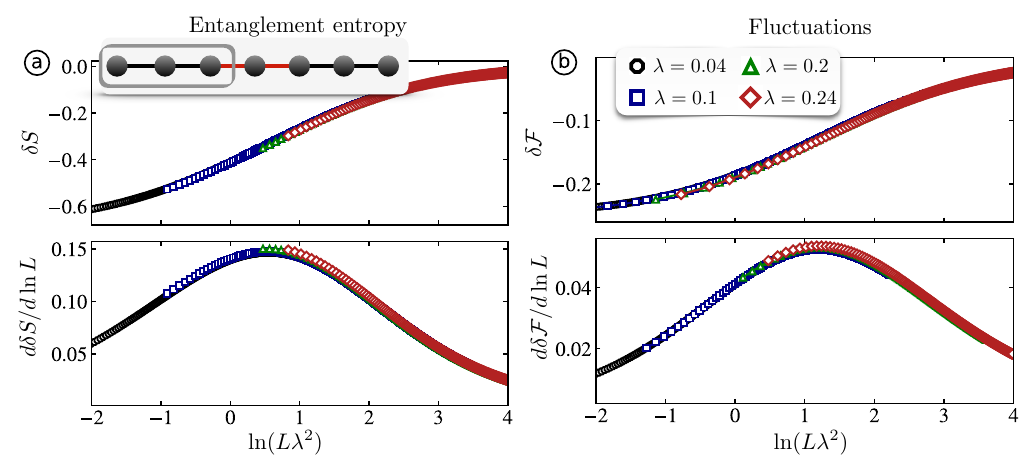
Figure 8: a (cid:13) Entanglement entropy for varying positions of the quantum dot, ex- cluding the dot from subsystem A , as illustrated in the inset of the upper panel. As for the single impurity bond, δ S is defined as the difference of even and odd parities of the quantum dot position. The derivative of the difference with respect to ln L , where L is the total system size, is shown in the lower panel, where a crossover can be observed at L λ 2 ∼ 1. b (cid:13) The same for charge